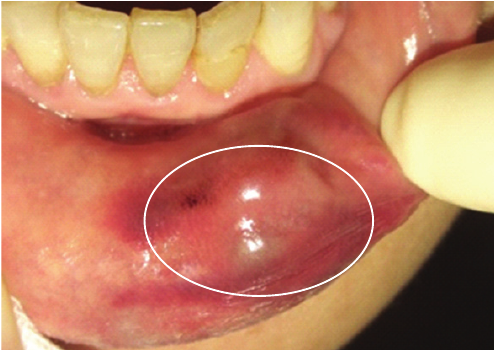
Figure 1: A dark-red-colored tumor, measuring approximately 1cm in diameter, that was tender and smooth, with a clear boundary being seen in the left side of the lower lip (inside white circle).